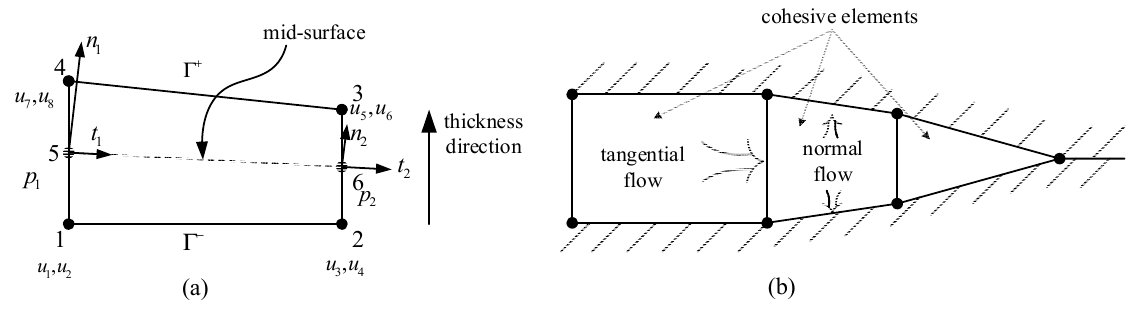
Figure 3. ( a ). Schematic of two-dimensional pore pressure cohesive element. ( b ) Fluid flow in cohesive element. The pore pressure cohesive element can simulate a tangential flow and leak-off from fracture to rock matrix.